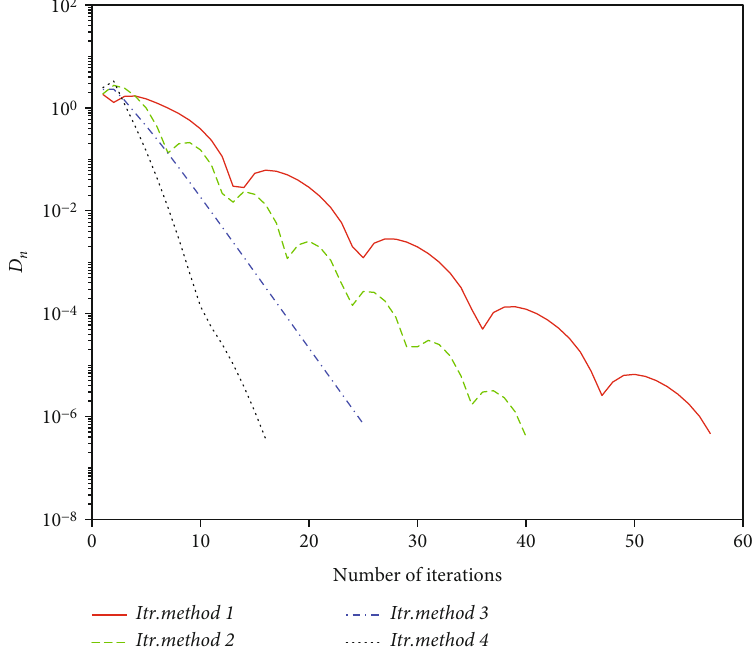
Figure 7: All methods are compared computationally while x